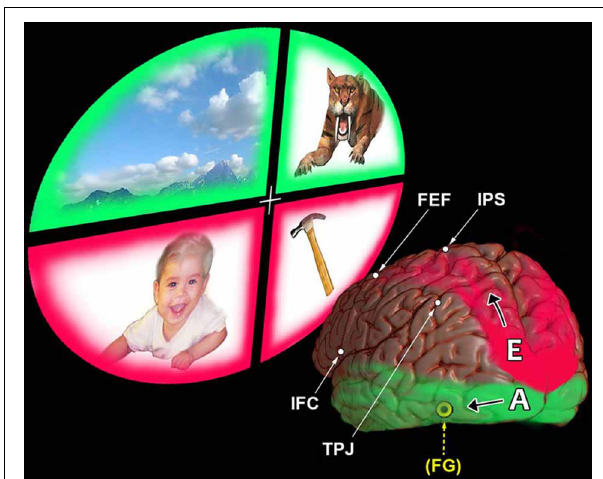
FIGURE 1 | Egocentric and allocentric attentive processing; major differences in their efficiencies. This view contrasts our top–down dorsal egocentric networks with those other networks representing our ventral allocentric , bottom–up pathways. The reader’s vantage point is from a position behind the left hemisphere, looking at the lower end of the occipital lobe. This person’s brain is shown gazing up and off to the left into quadrants of scenery. The items here are imaginary. The baby and the hammer are within reach, in the space down close to the person’s body. The scenery above and the tiger are off at a distance, out of reach. Starting at the top of the brain are the two modules of the dorsal , top–down attention system: the intraparietal sulcus (IPS) and the frontal eye field (FEF). They serve as the attentive vanguards linked with our subsequent sensory processing and goal-oriented executive behavior. Notice how they are overlapped by the upward trajectory of the upper parietal → frontal egocentric (E) system. This is a self-referential system. Its arching red pathway is shown as beginning in the upper occipital region. Notice that a similar red color also surrounds the lower visual quadrants containing the baby (at left) and the hammer (at right). Why? To indicate that this dorsal, “northern” attention system attends more efficiently—on a shorter path with a lesser “wiring cost”—to these lower visual quadrants. This enables our parietal lobe senses of touch and proprioception to “handle” easily such vitally important tangible items down close to our own body. In contrast, our two other modules for cortical attention reside lower down over the outside of the brain. They are the temporo-parietal junction (TPJ) and the regions of the inferior frontal cortex (IFC). During bottom–up attention, we activate these two modules of the ventral attention system chiefly on the right side of the brain. There, they can engage relatively easily the networks of allocentric processing nearby (A). The green color used to represent these lower temporal → frontal networks is also seen to surround the upper visual quadrants. Why? This is to suggest the ways this lower (“southern”) pathway is poised globally to use its two different specialized systems of pattern recognition. One is based on our sense of vision , the other on our sense of audition . Both serve not only to identify items off at a distance from our body but also to infuse them instantly with meaningful interpretations. The yellow FG in parenthesis points to this lower pathway’s inclusion of the left fusiform gyrus. This region, hidden on the undersurface of the temporal lobe, contributes to complex visual associations, including our sense of